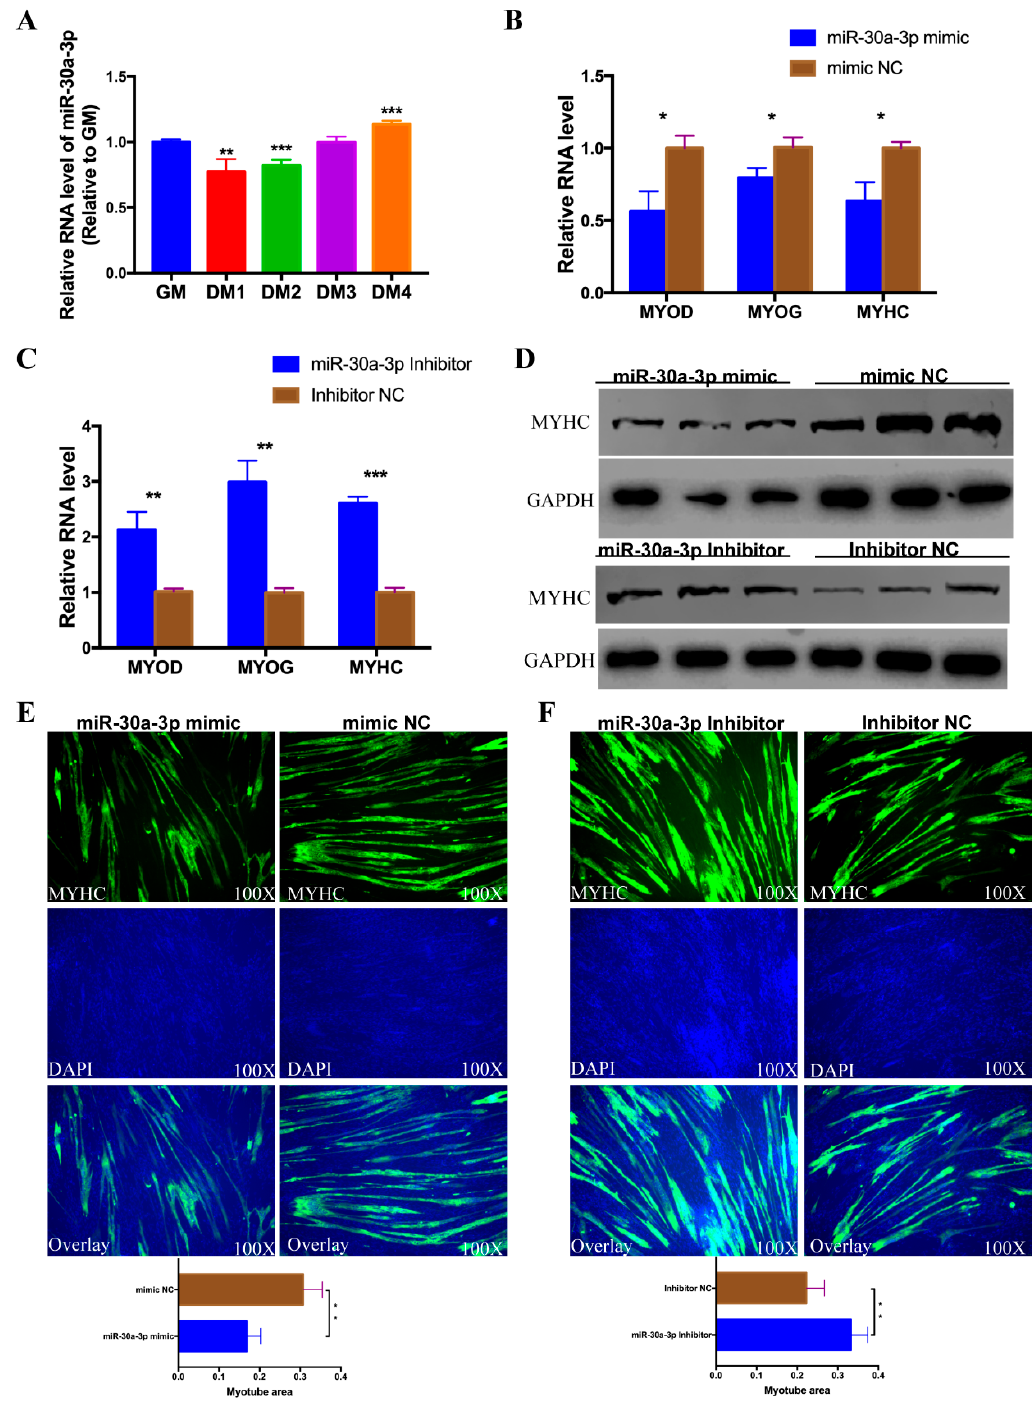
Figure 5. miR-30a-3p represses CPM differentiation. ( A ) The expression profile of miR-30a-3p in the process of CPMs induced differentiation. ( B ) The expression of MYOD , MYOG and MYHC in CPMs after over-expression of miR-30a-3p. ( C ) The expression of MYOD , MYOG and MYHC in CPMs after knock-down of miR-30a-3p. ( D ) The protein level of MYHC in CPMs after over-expression and knock-down of miR-30a-3p. ( E ) Immunofluorescence analysis of MYHC-staining cells after over-expression miR-30a-3p in CPMs. ( F ) Immunofluorescence analysis of MYHC-staining cells after knock-down of miR-30a-3p in CPMs. * p < 0.05; ** p < 0.01; *** p < 0.001.